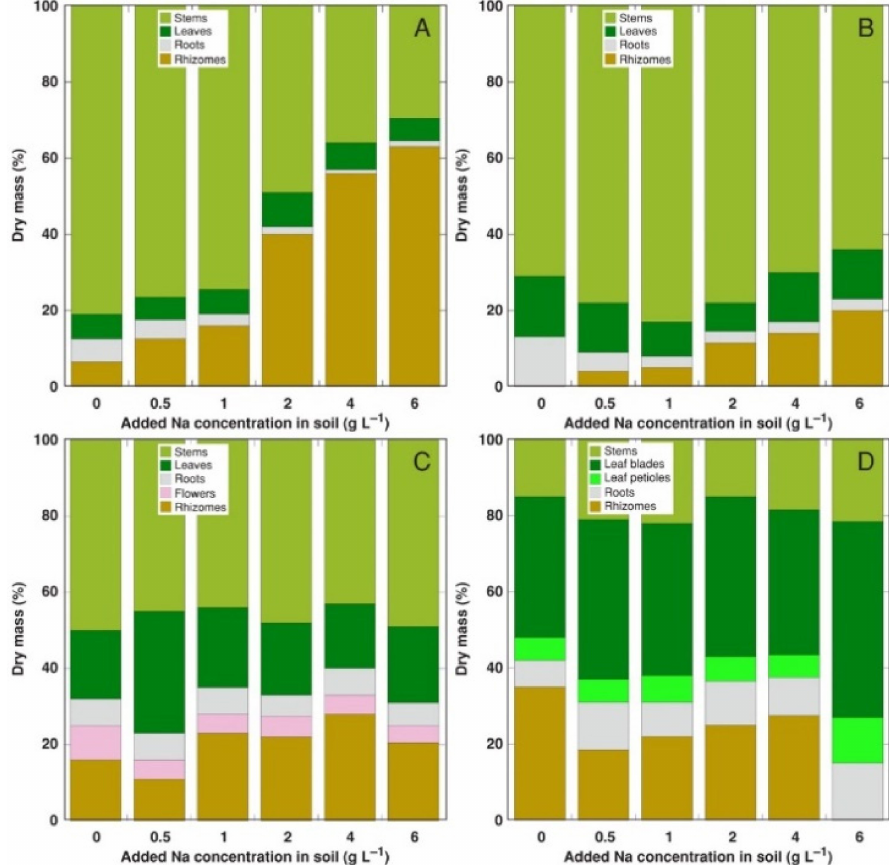
Figure 2. Relative changes in biomass partitioning in Calystegia sepium plants from accessions CSe1 ( A ), CSe2 ( B ), CSe3 ( C ) and Calystegia soldanella (CSo) ( D ) plants due to increasing substrate salinity. Na + was added in a form of